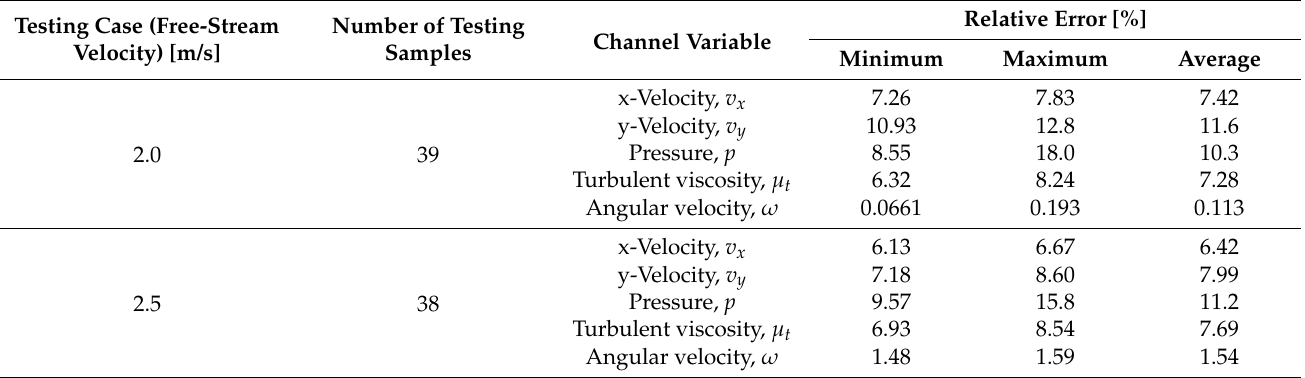
Table 7. Relative errors produced by Model 3 in each channel, for the individual testing cases of v ∞ = 2.0 and 2.5